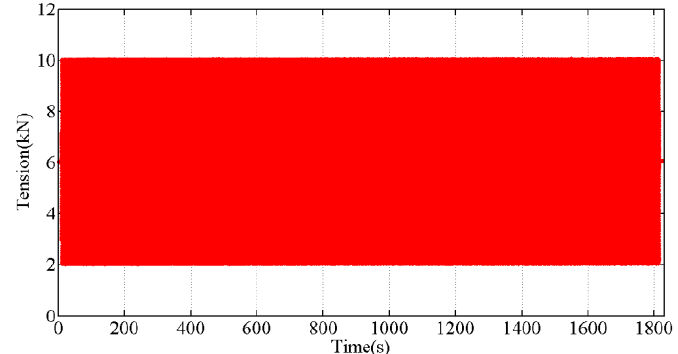
Figure 7. The measured tension during the sensor fatigue stretching experiment.